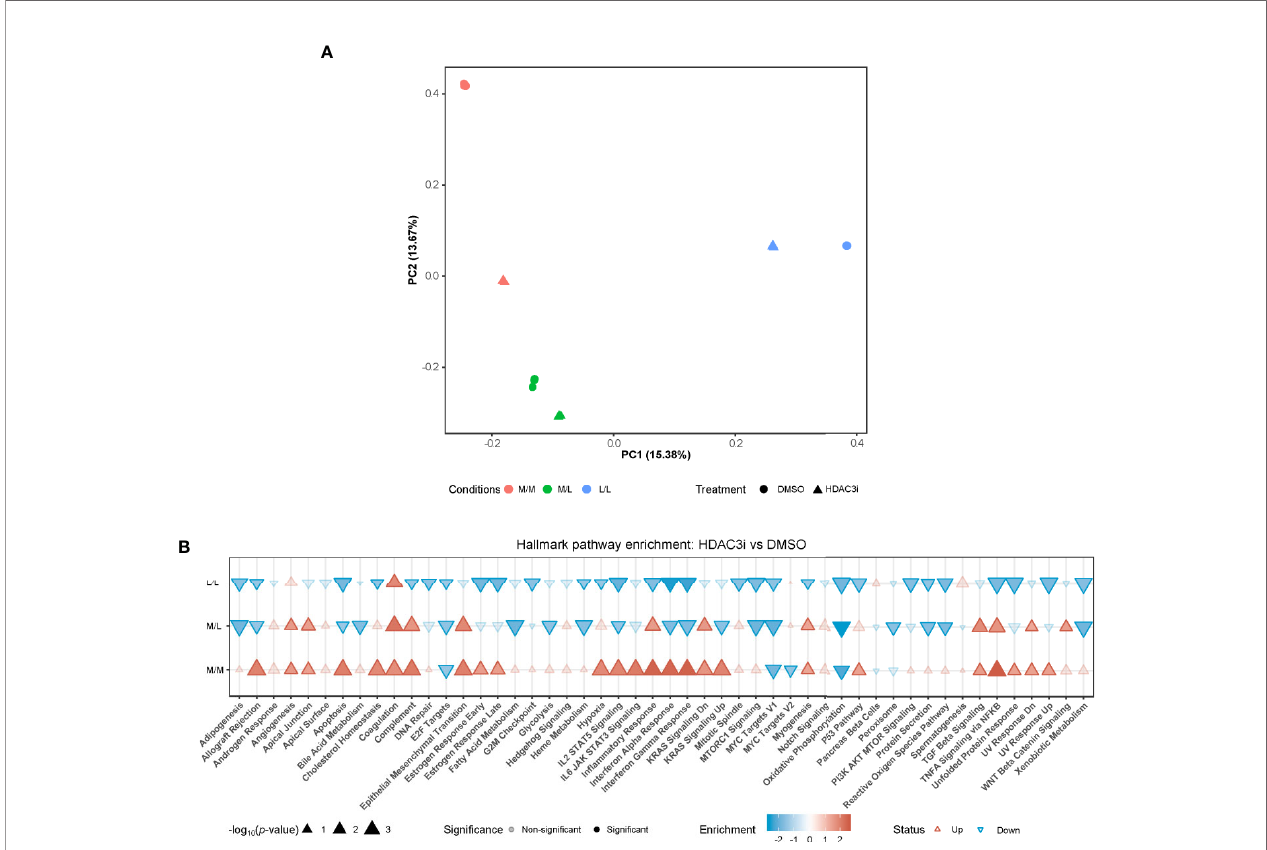
FIGURE 4 | Monocytes pretreatment with HDAC3i induced transcriptional changes of M1 macrophages. Primary human CD14 + monocytes were treated with 500 nM of HDAC3i or DMSO prior to polarization with IFN g overnight yielding M1 macrophages. The macrophages were then washed and exposed to 3 conditions: non-treated with LPS naïve ( “ M/M ” ), non-tolerized ( “ M/L ” ) or tolerized ( “ L/L ” ). RNA was isolated from the macrophages 3 h after last LPS stimulation (n=3). (A) Visualization of the fi rst ( “ PC1 ” ) and second ( “ PC2 ” ) principal components calculated from the RNA-sequencing data annotated with the percentage explained variance. (B) Hallmark enrichment analysis when comparing HDAC3i with DMSO-treated cells for the different tolerization states. The direction and color of the arrow indicates the direction and size of the enrichment score, the size of the arrow represents is proportional to the – log 10 ( p -value), and non-transparent arrows represents signi fi cantly affected